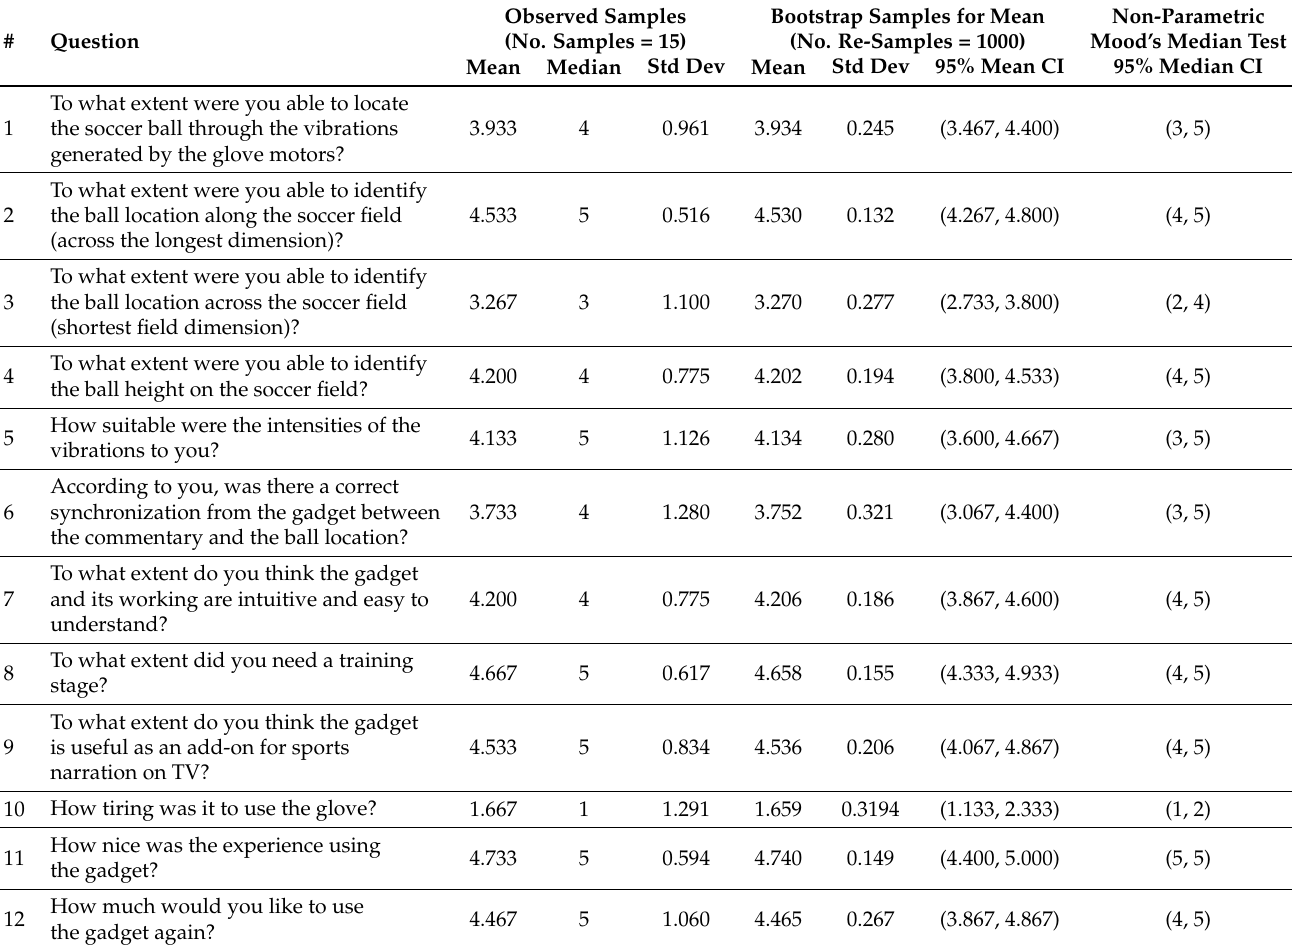
Table 3. Usability questions, user experience questions and statistical results.